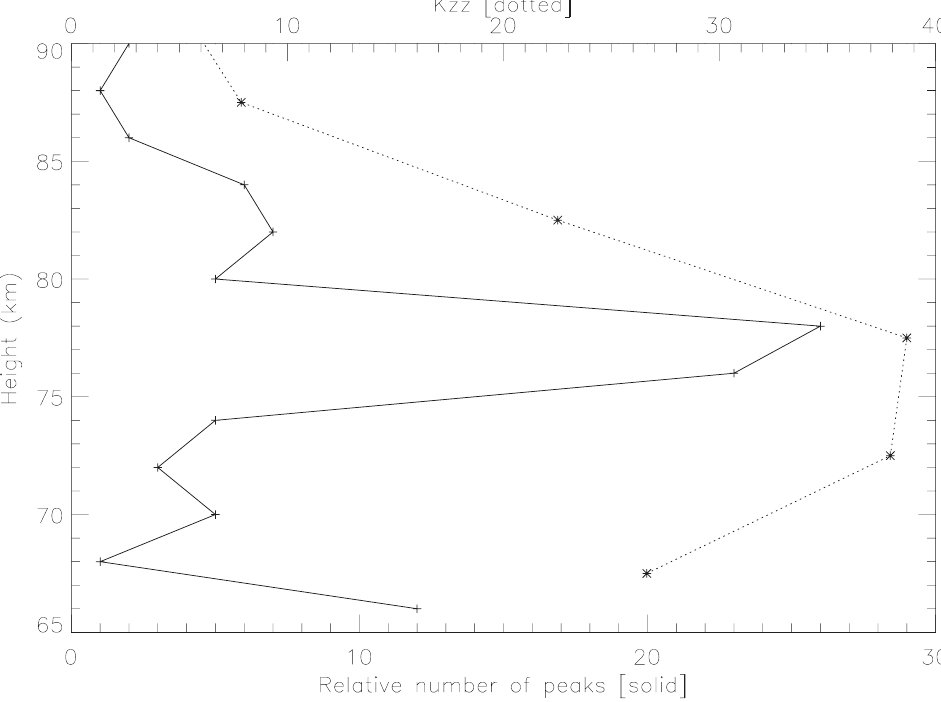
Fig. 5. Summertime profile of the estimated turbulent diffusion, K zz (solid line), with a superimposed profile showing the corresponding number of SNR peaks (dotted line) observed during the summer months